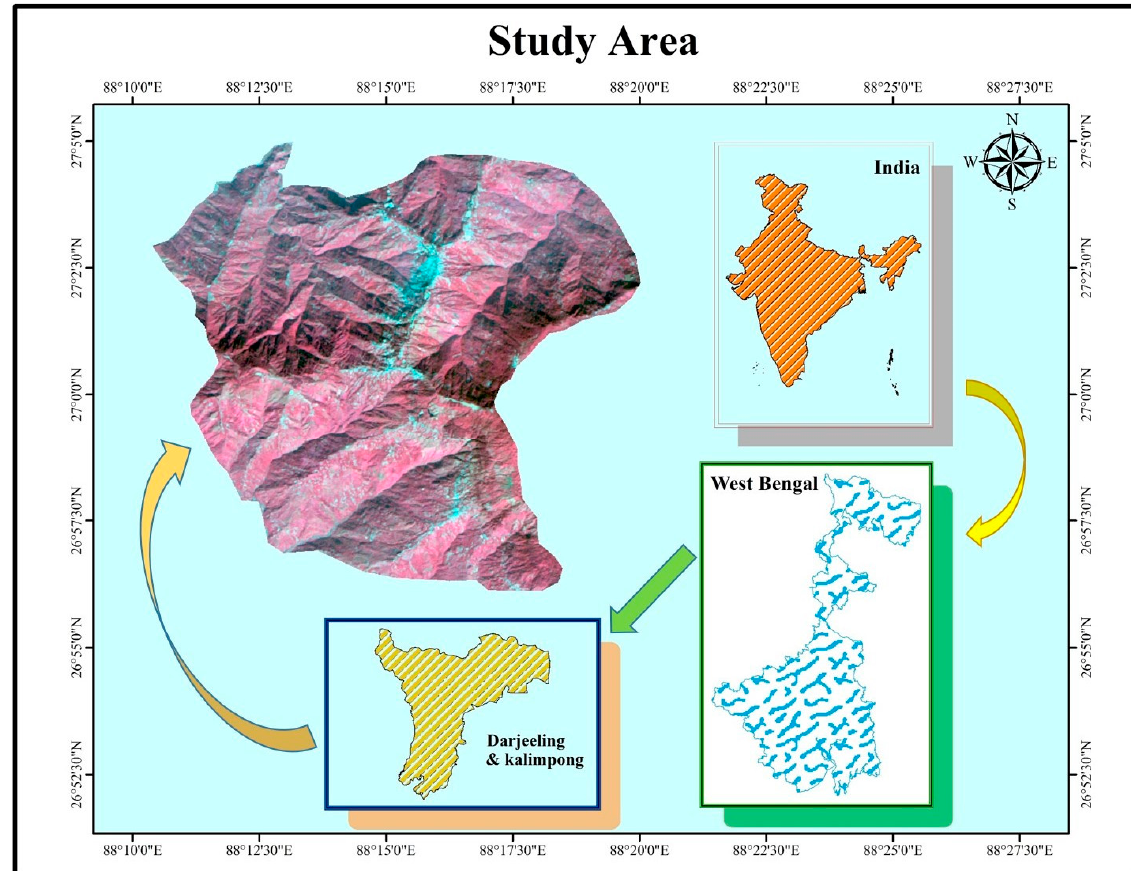
Figure 1. The study area shows a part of the Darjeeling district.